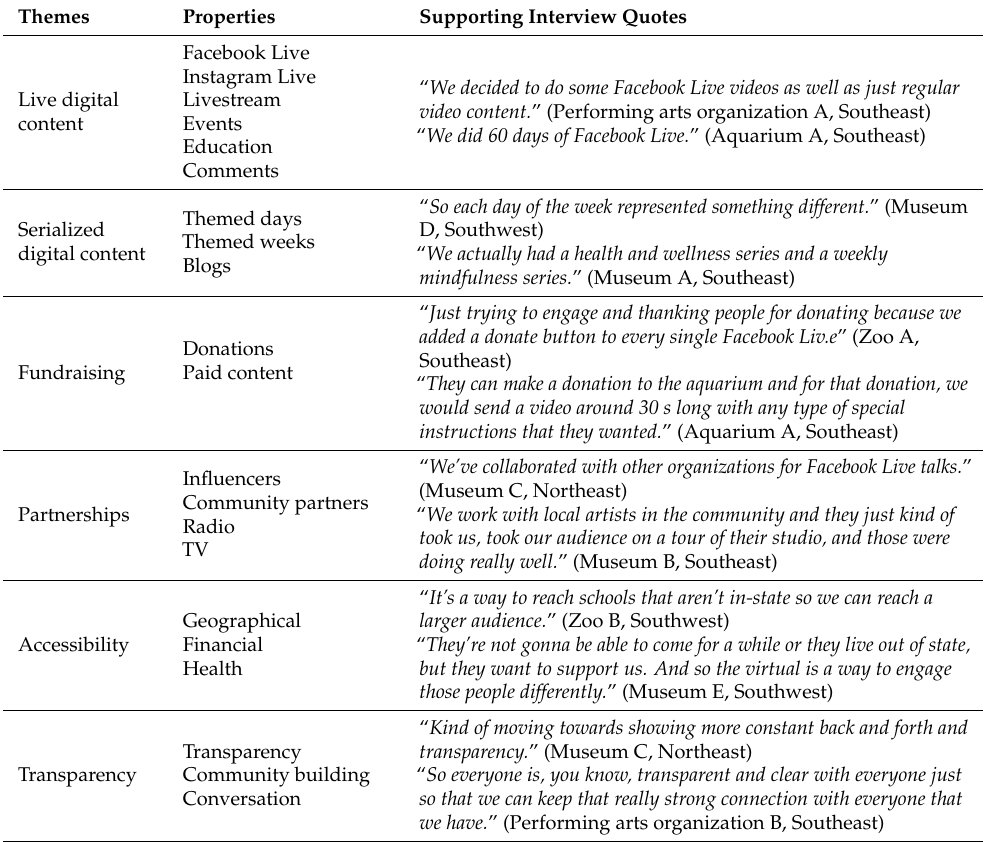
Table 1. Supporting quotes for the identified